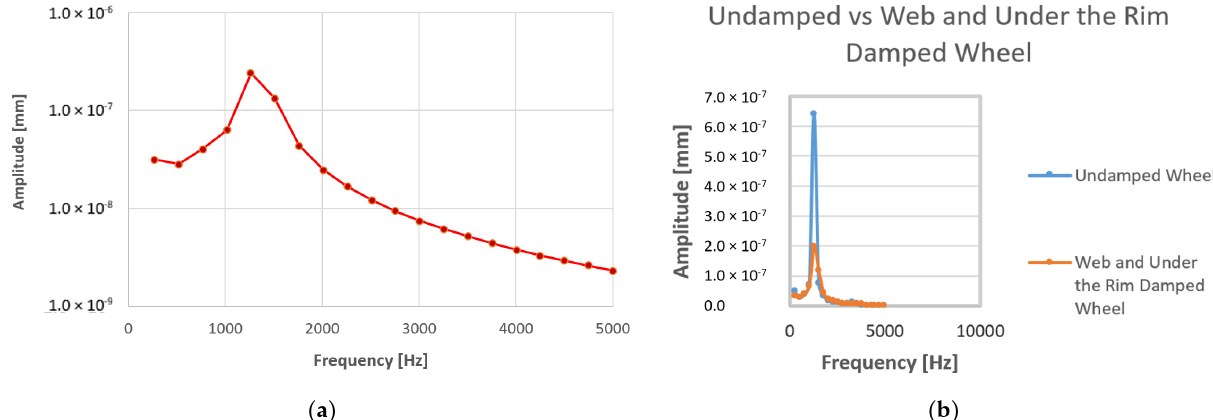
Figure 16. Harmonic response analysis in the radial direction with viscoelastic damping layer on both sides of the web and under the rim. ( a ) Radial harmonic excitation of the wheel mounted with viscoelastic layer on both sides of the web and under the rim. ( b ) Radial excitation results of the wheel without (black) and with (red) viscoelastic layer mounted on the web and under the rim on both sides of the wheel.